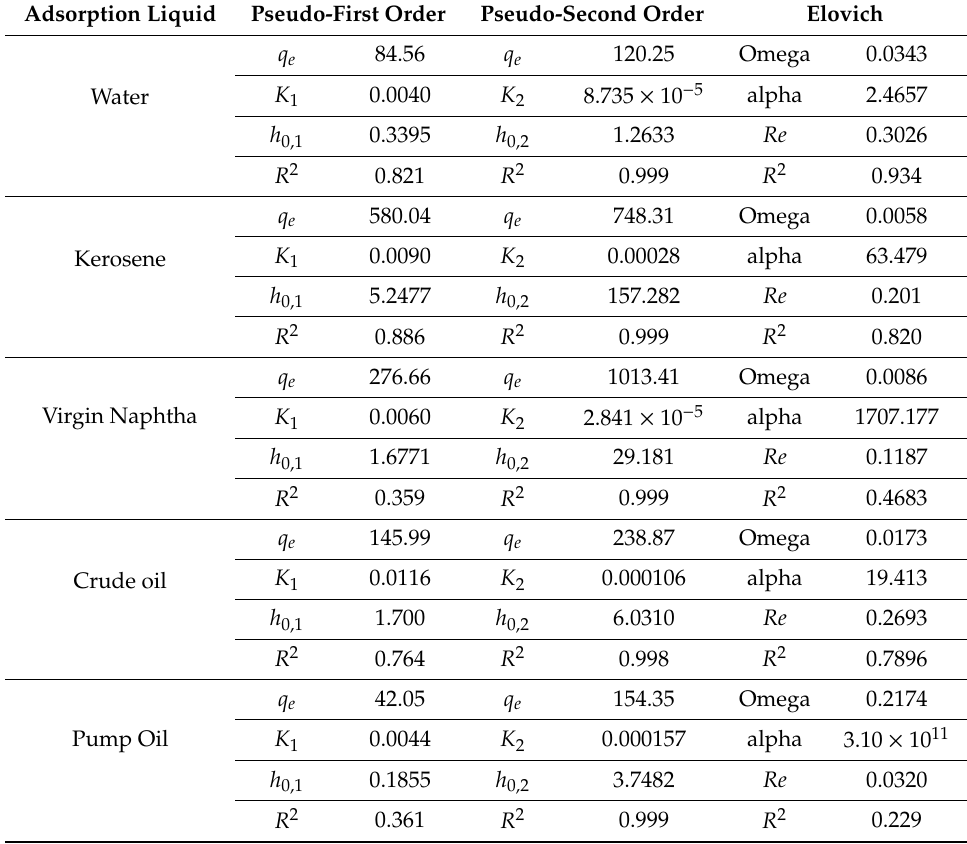
Table 7. The kinetic coe ffi cients of PFO, PSO and Elovich models for 3-EGF foam.